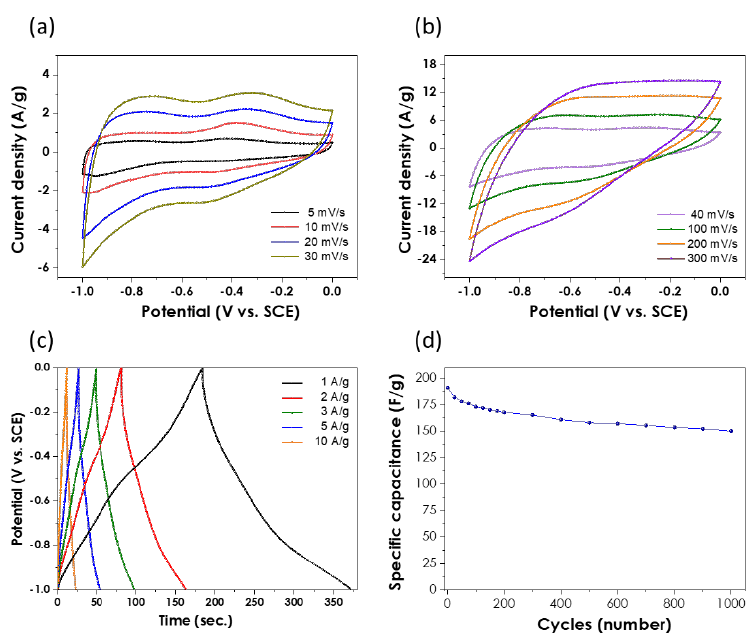
Figure 4. Cyclic voltammograms at scan rates of ( a ) 5–30 mV/s, ( b ) 40–300 mV/s, ( c ) charge–discharge curves (current density: 1–10 A/g), and ( d ) cycling performance of the nano-Fe 3 O 4 /CNT composite electrode (1 A/g) (electrolyte: 1 M Na 2 SO 3